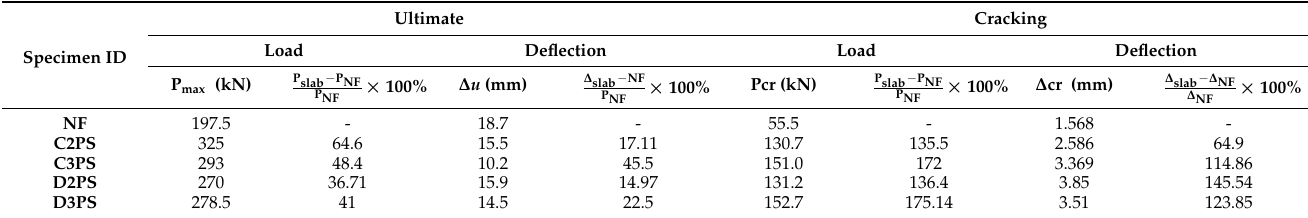
Table 4. Load and deflection at ultimate point and cracking